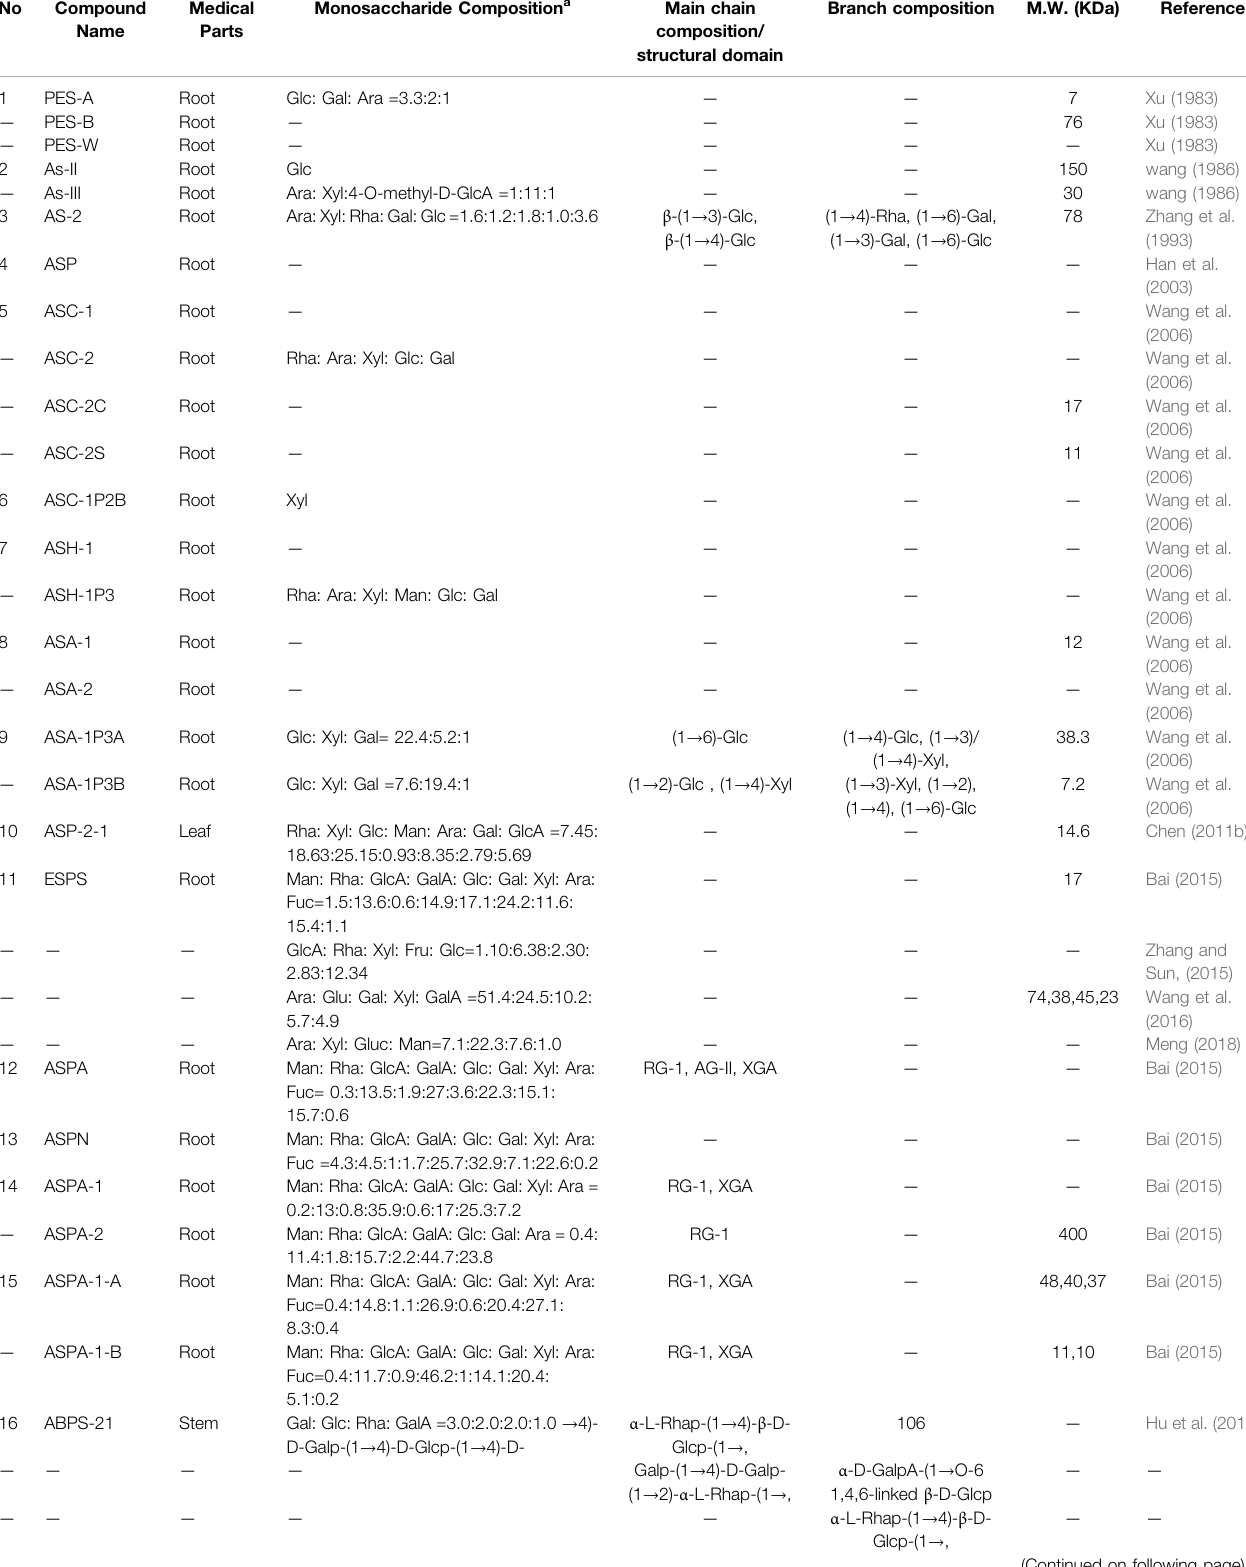
TABLE 2 | S tructural characterization of polysaccharides isolated from the different parts of Eleutherococcus